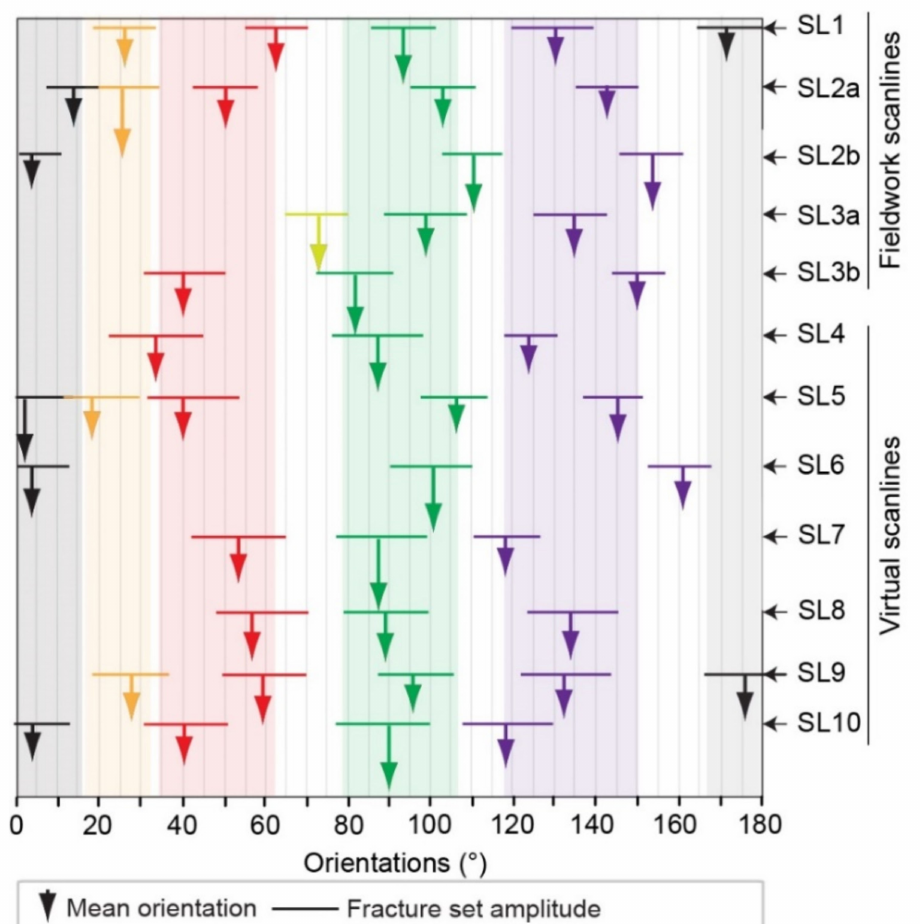
Figure 13. Plot displaying the mean orientation with arrows of each collected fracture set from NH scanlines. Each arrow was characterized by its own length, which corresponds to the fracture set abundance. The horizontal line above each arrow corresponds to the standard deviation of each fracture set, using an interval of confidence of 75% (see [68] for more explanations). Each color arrow corresponds to a fracture set. Orange arrow: NNE/SSW fracture set, red arrow: NE/SW fracture set, green arrow: E/W fracture set, yellow arrow: NNW/SSE fracture set, purple arrow: NW/SE fracture set, and black arrow: N/S fracture